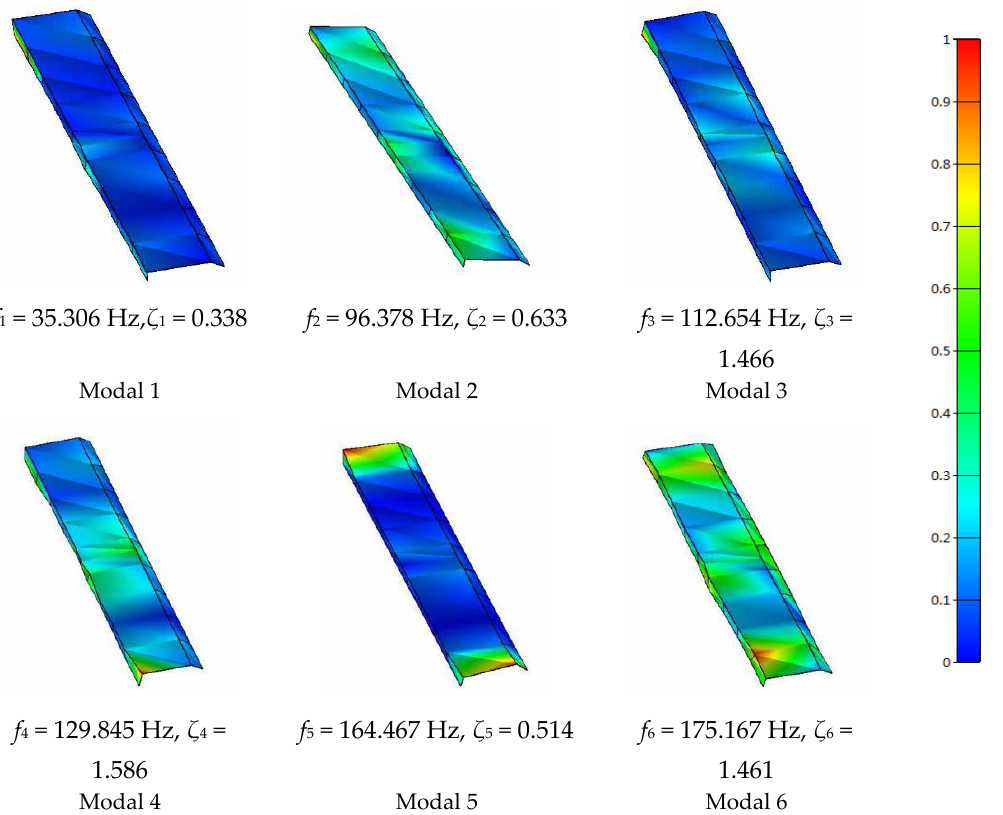
Figure 11. The first 6 order modal analysis results.